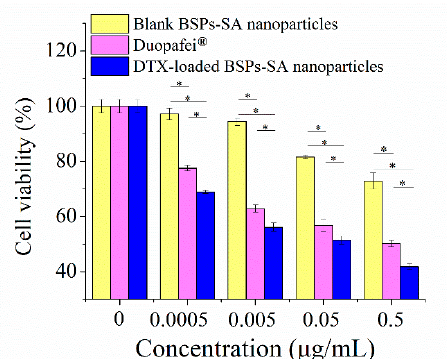
Figure 7. Inhibitory effects of blank BSPs-SA nanoparticles, Duopafei ® , and DTX-loaded BSPs-SA